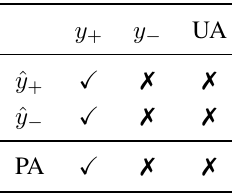
Table 1. Confusion matrix with the reference information, y or negative ( − ) class, in the columns and the classified class ˆ y in the rows. Only y are available during OCC, which complicates the selection and training of a suitable